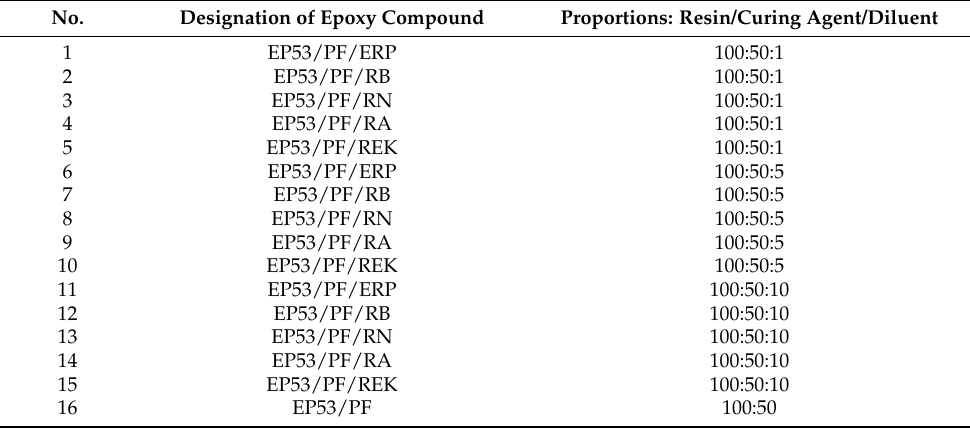
Table 3. Compositions and labels of epoxy compounds based on Epidian 53/PF